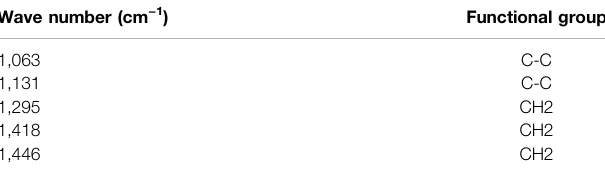
TABLE 3 | Wave number and functional group [the values were assigned by comparing with the spectra reported by Kida et al. (2016)]. Wave number (cm − 1